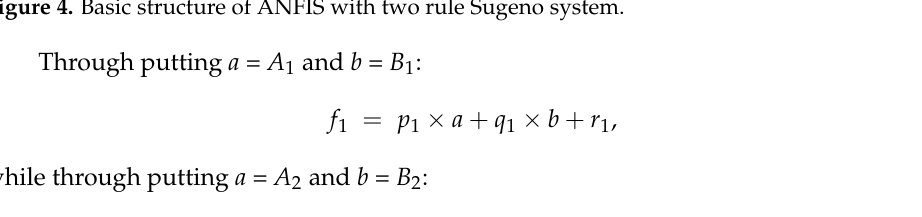
Figure 4. Basic structure of ANFIS with two rule Sugeno system.